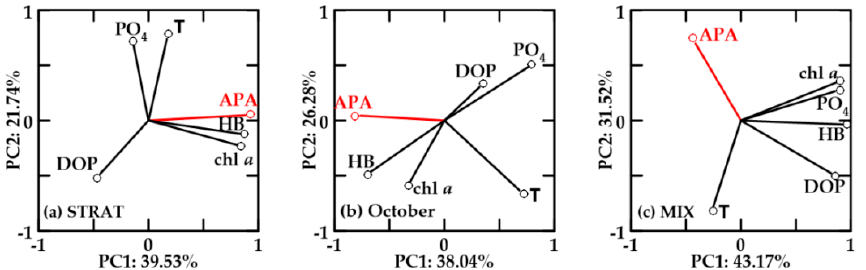
Figure 8. Principal component analysis (PCA) for relevant variables in oxygen-saturated new-FW waters during ( a ) STRAT, ( b ) October, and ( c ) MIX. Variables: alkaline phosphatase activity (APA), dissolved organic phosphorus (DOP), orthophosphate (PO 4 ), chlorophyll a (chl a ), and heterotrophic bacteria (HB). PCA was constructed with log-transformed values of respective parameters.